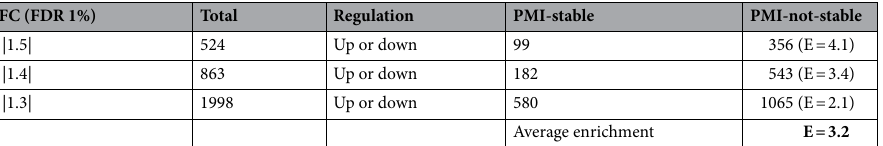
Table 2. Brain activity-dependent genes are enriched in the population of genes affected by the simulated PMI. We tested three groups of genes using fold change (FC) cutoffs of 1.3, 1.4 and 1.5 (corresponding to the absolute values of the ratio of expression of high brain activity genes divided by the expression of low activity brain genes). The significance used was FDR ≤ 1%. A total of 6754 genes (43%) were detected as stable, 5947 (38%) were identified as not stable from 0 to 24H simulated PMI. We then calculated the enrichment in brain activity-dependent genes inside each group and labeled these as ‘PMI not-stable’. Enrichment was calculated as the ratio between the quantity of brain activity-dependent genes that were not stable as a function of simulated PMI divided by the quantity of brain activity-dependent genes that were stable. E Enrichment.